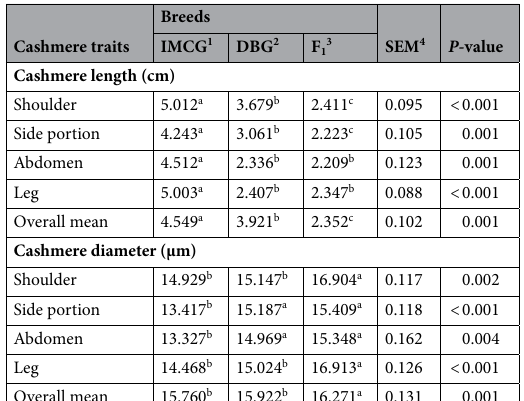
breeds were significant ( P = 0.002), with the lowest value obtained for F 1 and the highest for DBG. All cashmere intensity traits were significantly different ( P < 0.001) among breeds except elongation at break which was different at ( P = 0.032). IMCG recorded the highest elongation at break ( P = 0.032), elongation % and EYS1.5 ( P < 0.001). While DBG recorded the highest values for intensity traits of breaking strength, work, strength and yield point ( P < 0.001). For all cashmere intensity traits, F 1 won intermediate positions between the values of both parents breeds. As for cashmere whiteness, the differentiation indicated significant ( P = 0.019) variability among breeds, while no significant differences were found between body sites within each breed. The highest degree of whiteness was observed on IMCG, followed by F 1 , while the lowest degree was obtained on DBG. Cortical cells dimensions. The mean length of the cortical cells of fibres from different body sites were slightly different ( P = 0.148) between the two parents breeds (94.57 vs 86.85 μm), whilst for diameters (5.86 vs 5.35 μm) were not significant. However, the abdomen site of IMCG showed the highest cortical cell length ( P = 0.045)